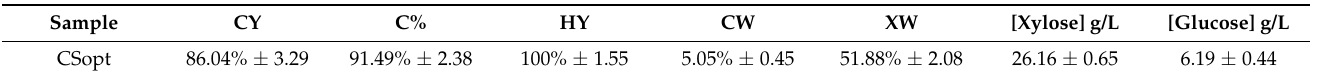
Table 5. Cellulose pulp and aqueous fraction characterization after the OV pretreatment with optimized factor settings. CW and XW are the mass of cellulose and xylan, respectively, recovered in the aqueous fraction respective to their initial contents in